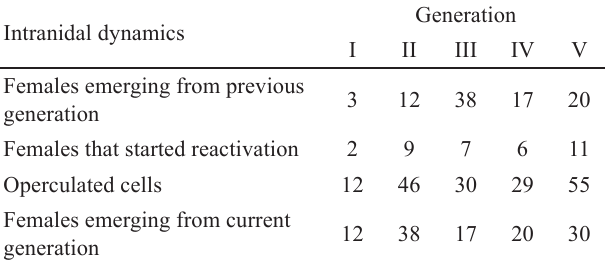
Table 1 . A summary of sororal actvities across five generations of Euglossa annectans .